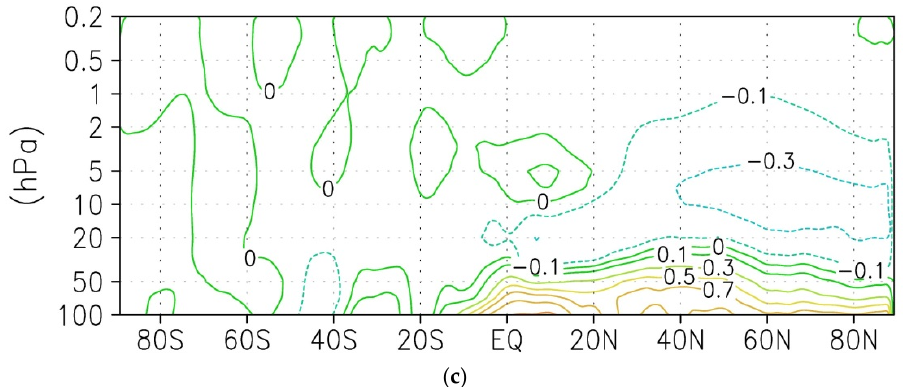
Figure 10. Change of residual stream function (kg/s 10 9 ) between the “warm” and “cold” winters in December ( a ), January ( b ) and February ( c ). After the contour with a value of 1, the next contours correspond to 1.5 and 2.